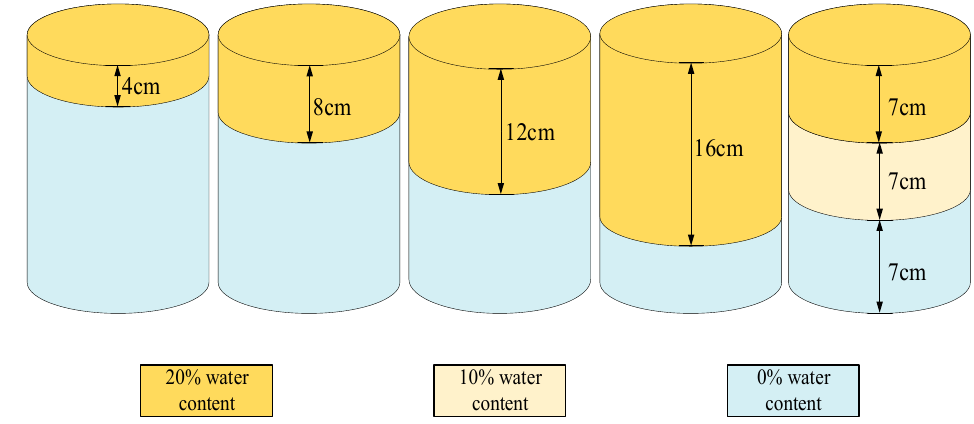
Figure 1. Schematic diagram of sample preparation.